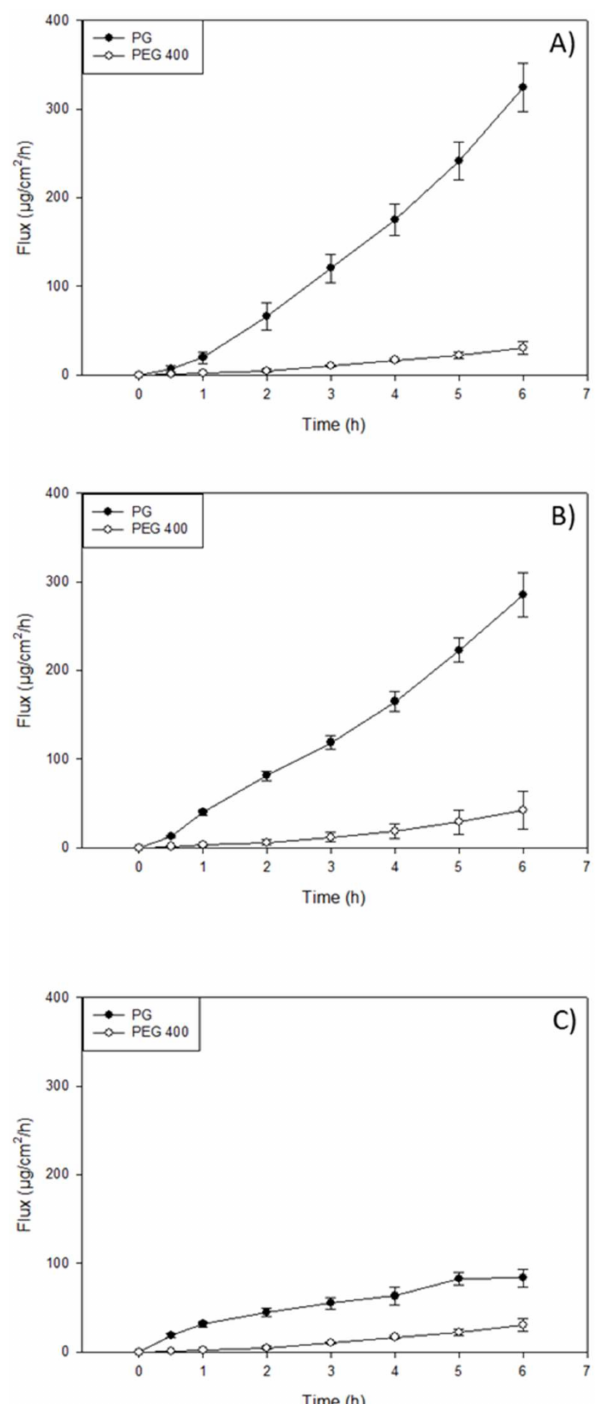
Figure 4. In vitro Franz cell/Strat-M ® permeation profile of resatorvid: ( A ) 5% simple solutions; ( B ) 2.5% simple solutions; and ( C ) 1.25% simple